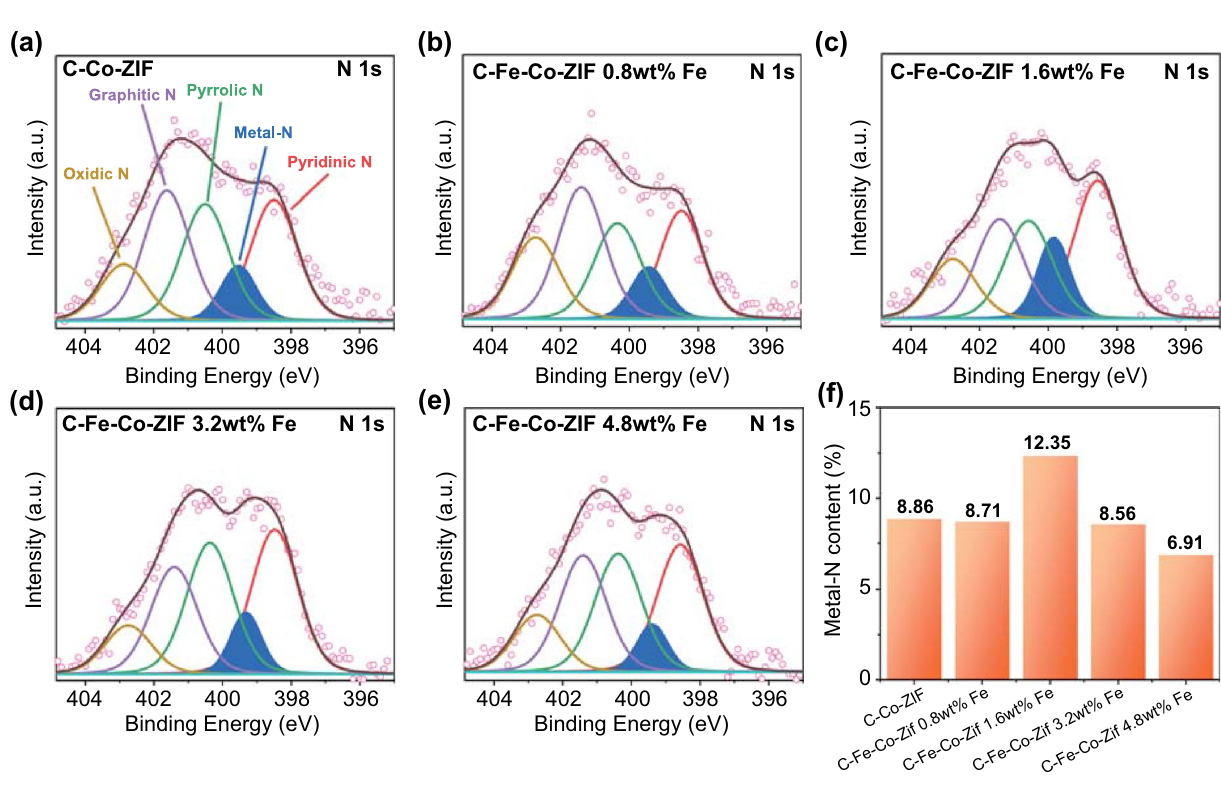
Fig. 4 N 1 s XPS of a C–Co-ZIF, b C–Fe–Co–ZIF-0.8 wt%-Fe, c C–Fe–Co–ZIF-1.6 wt%-Fe, d C–Fe–Co–ZIF-3.2 wt%-Fe, e C–Fe–Co–ZIF- 4.8 wt%-Fe. f The percentage of metal-N content among N species of C–Fe–Co–ZIF